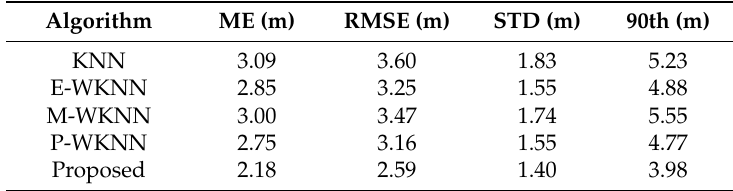
Table 2. Positioning performance comparison of the five algorithms.